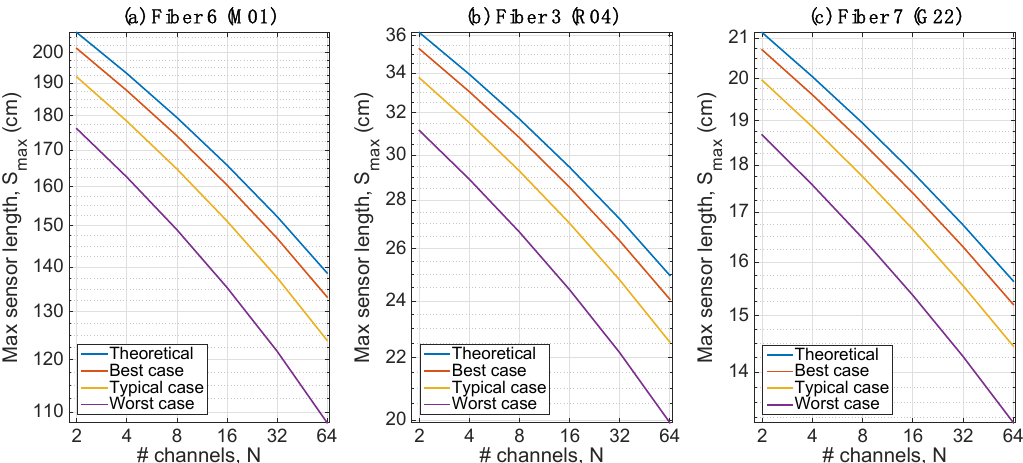
Figure 7. Maximum sensor length as a function of number of channels, accounting the impairments: ( a ) Fiber 6, M01; ( b ) Fiber 3, R04; ( c ) Fiber 7, G22.